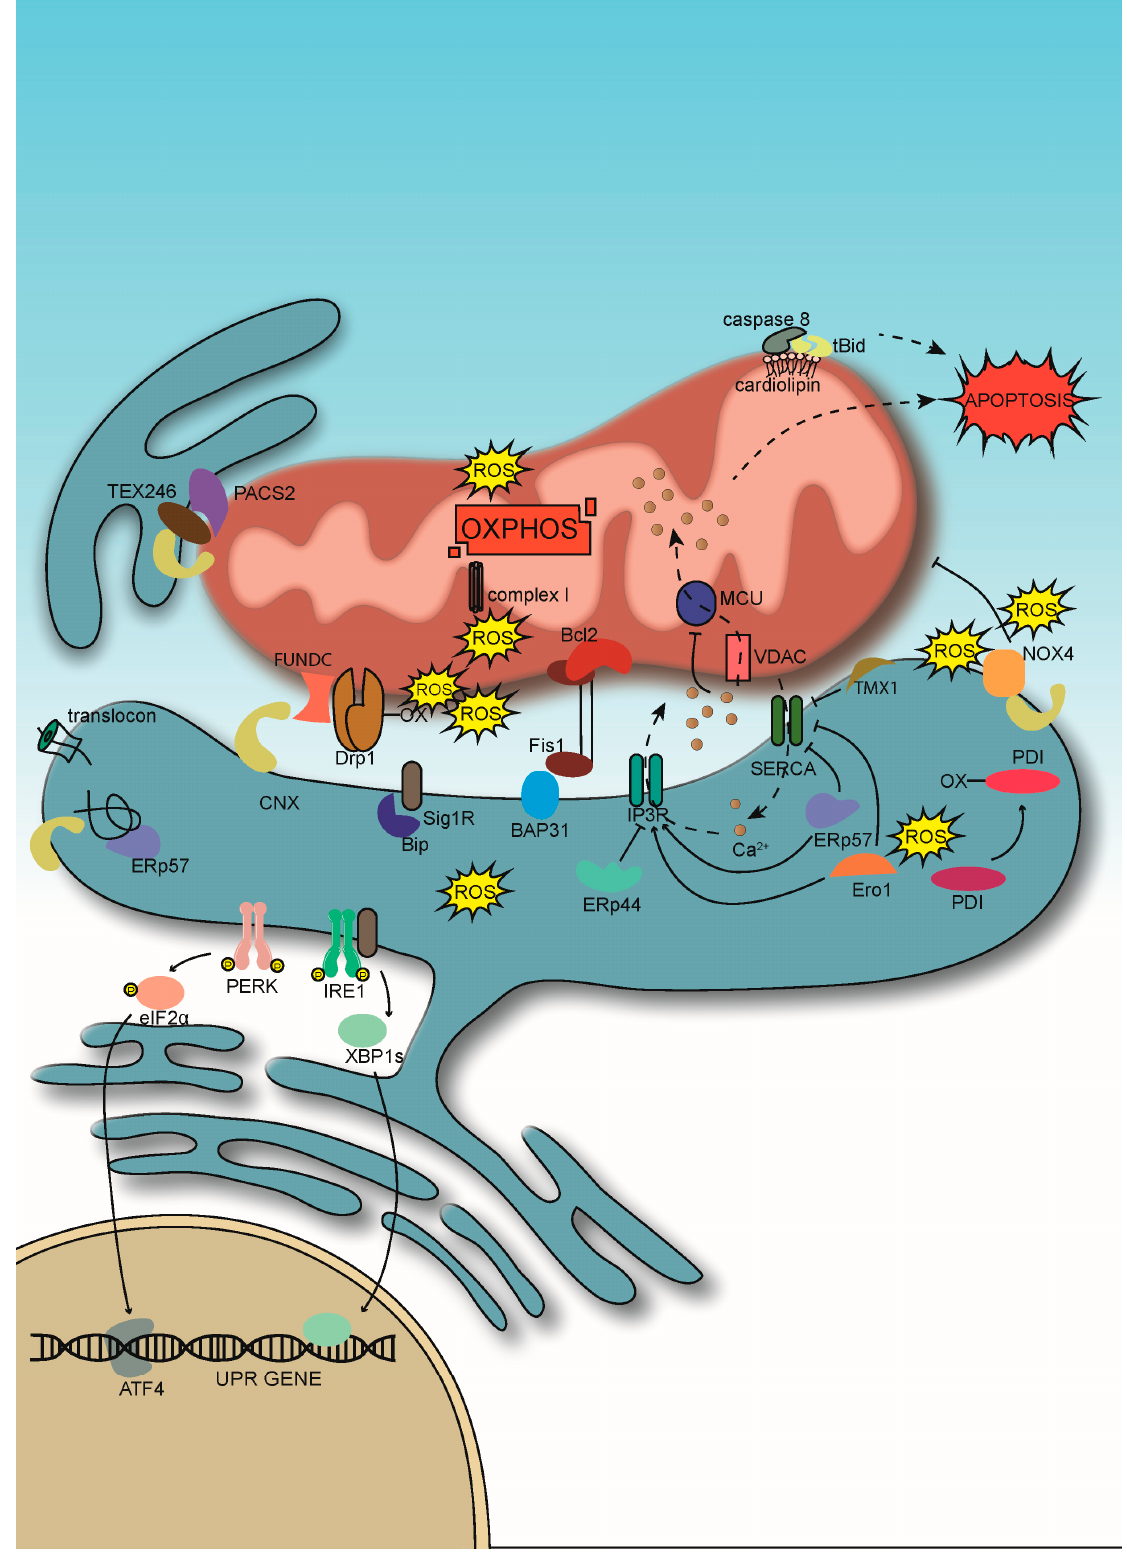
Figure 2. ER–mitochondria interactions under stress conditions. Basal reactive oxygen species (ROS) production increases, leading to a transfer of Ca 2+ from the ER to mitochondria, initially boosting oxidative phosphorylation (OXPHOS), but ultimately triggering apoptosis and autophagy. ER chaperones and oxidoreductases alter their homeostatic interaction patterns and associate with pro-apoptotic and pro-autophagic machineries. For details, see text.